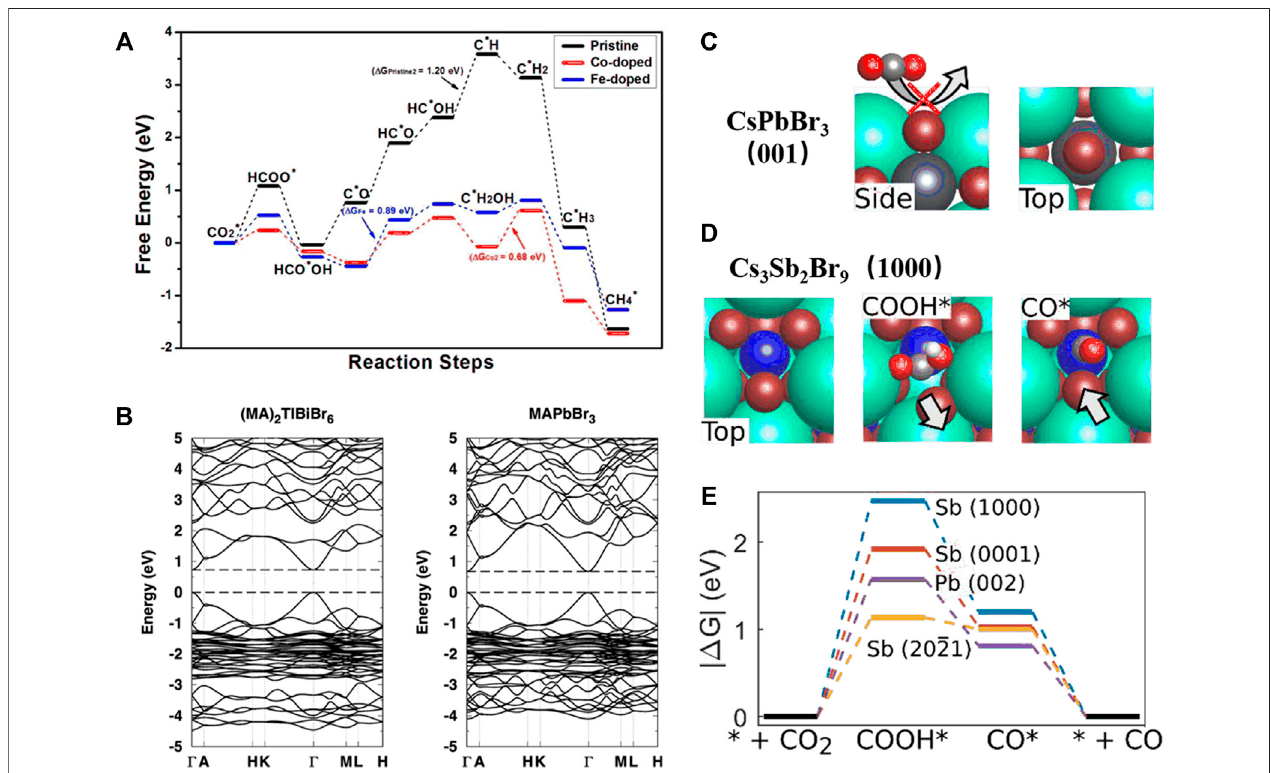
FIGURE4|(A) Thefree-energydiagramsofthemostfavoredpathsofCO 2 reductiononpristine,Co-dopedandFe-dopedCsPbBr 3 (Umarietal.,2014).Copyright (2019) Royal Society of Chemistry. (B) Calculated electronic band structures of (MA) 2 TlBiBr 6 and MAPbBr 3 (Melissen et al., 2015). Copyright (2016) Royal Society of Chemistry. Schematic of the (C) CsPbBr 3 (001) surface and (D) reactivity of highly exposed Cs 3 Sb 2 Br 9 (1000) surface. (E) Free-energy pathways for highly exposed